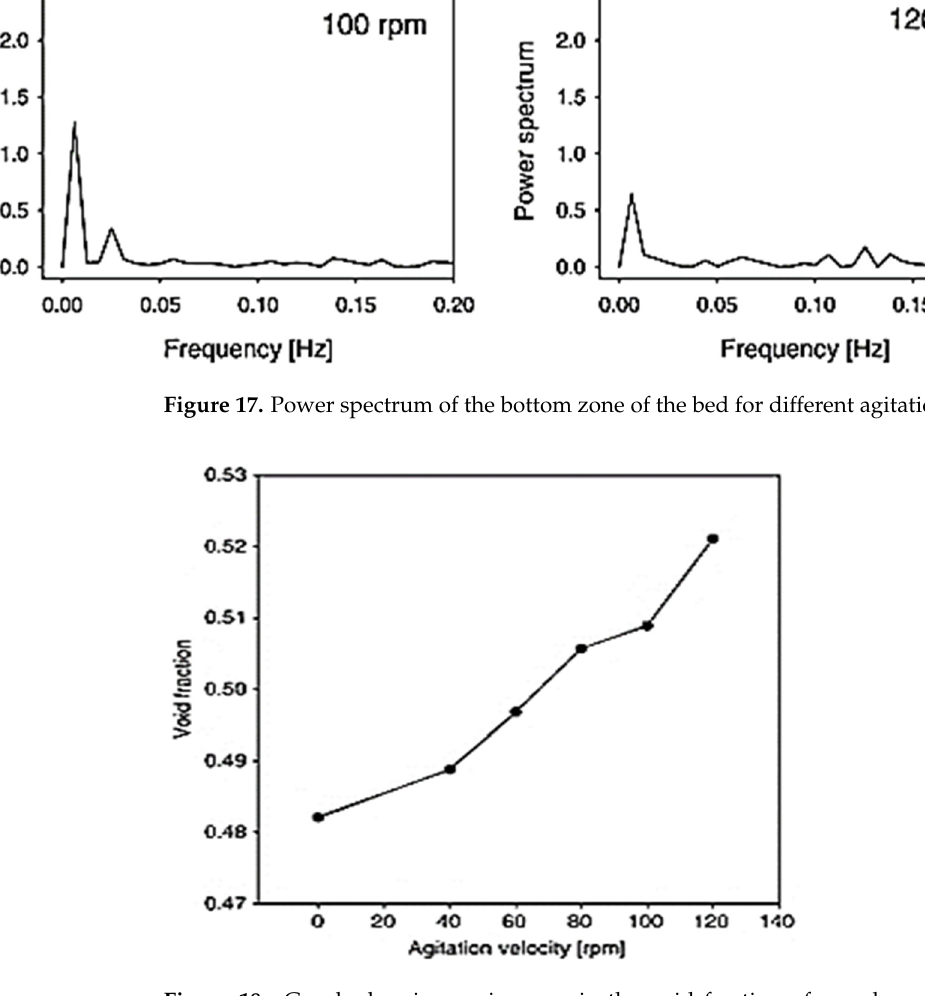
Figure 19. Graph of variation of bubble diameter with agitation speed [151].